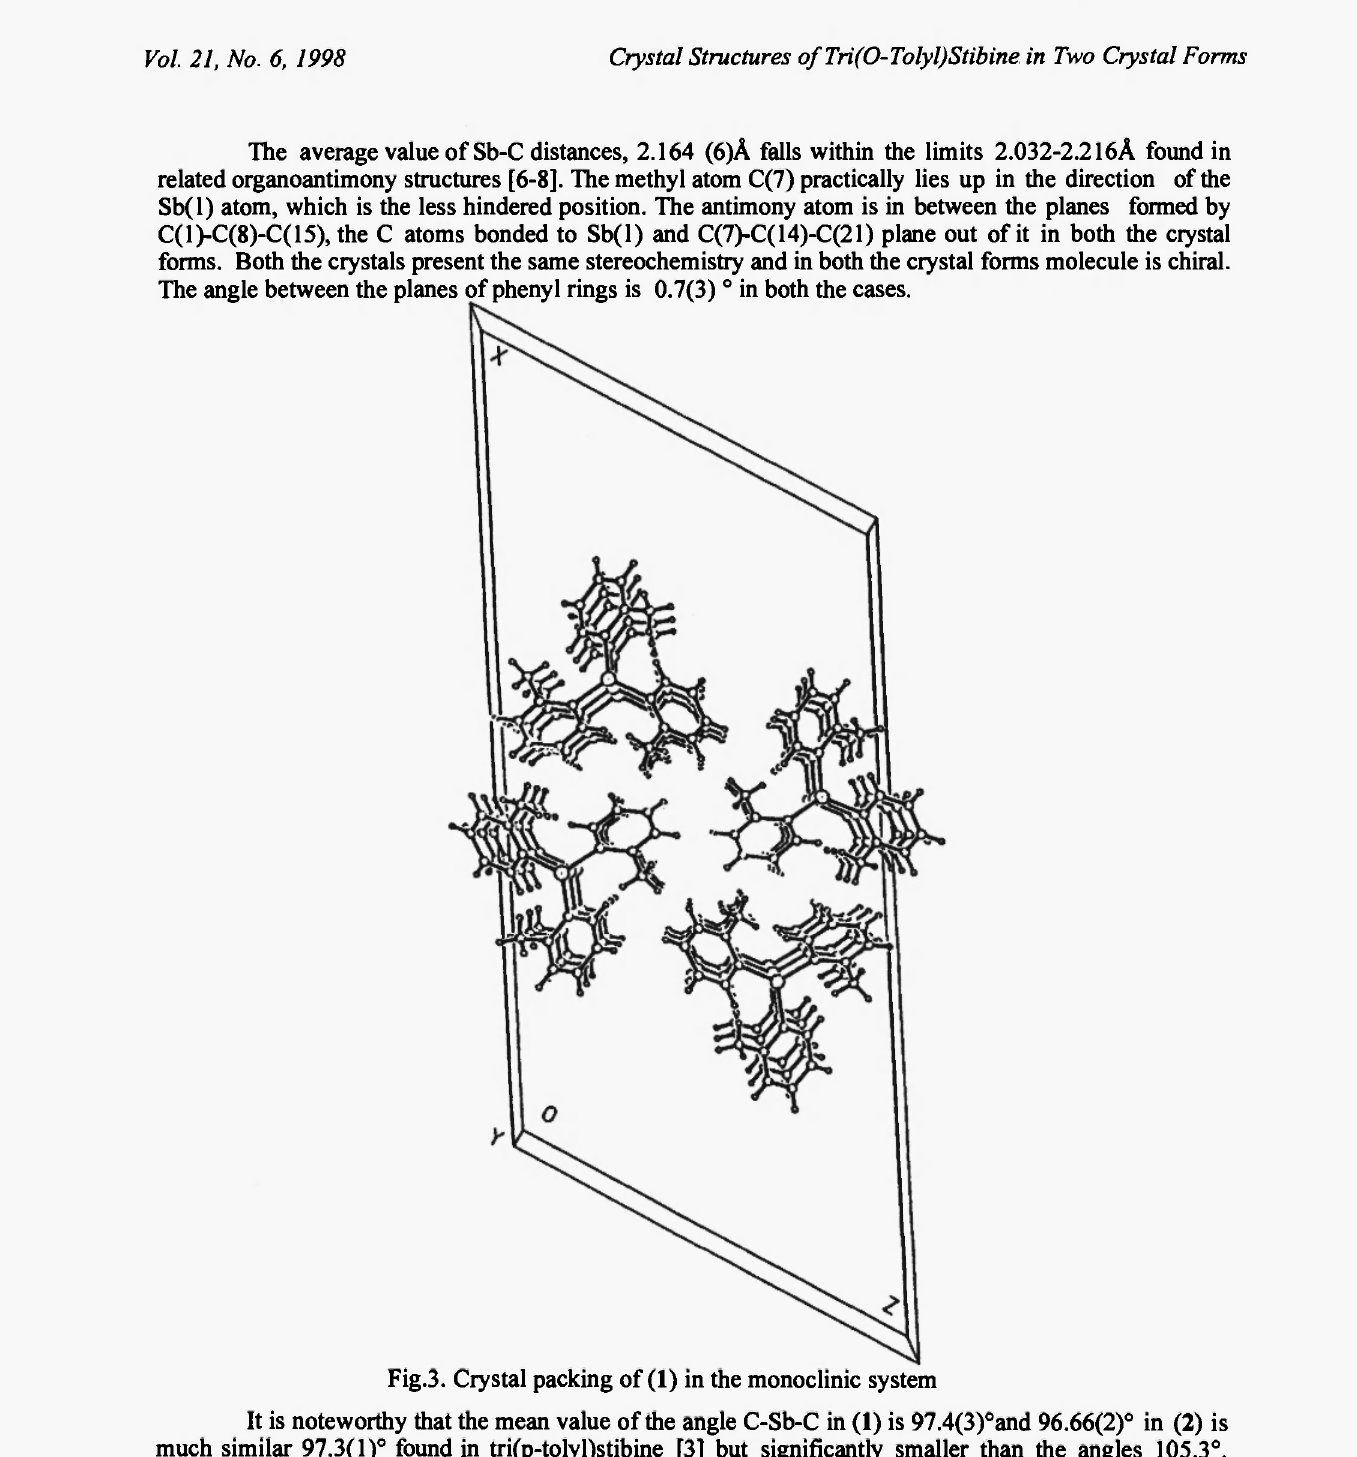
Fig.3. Crystal packing of (1) in the monoclinic